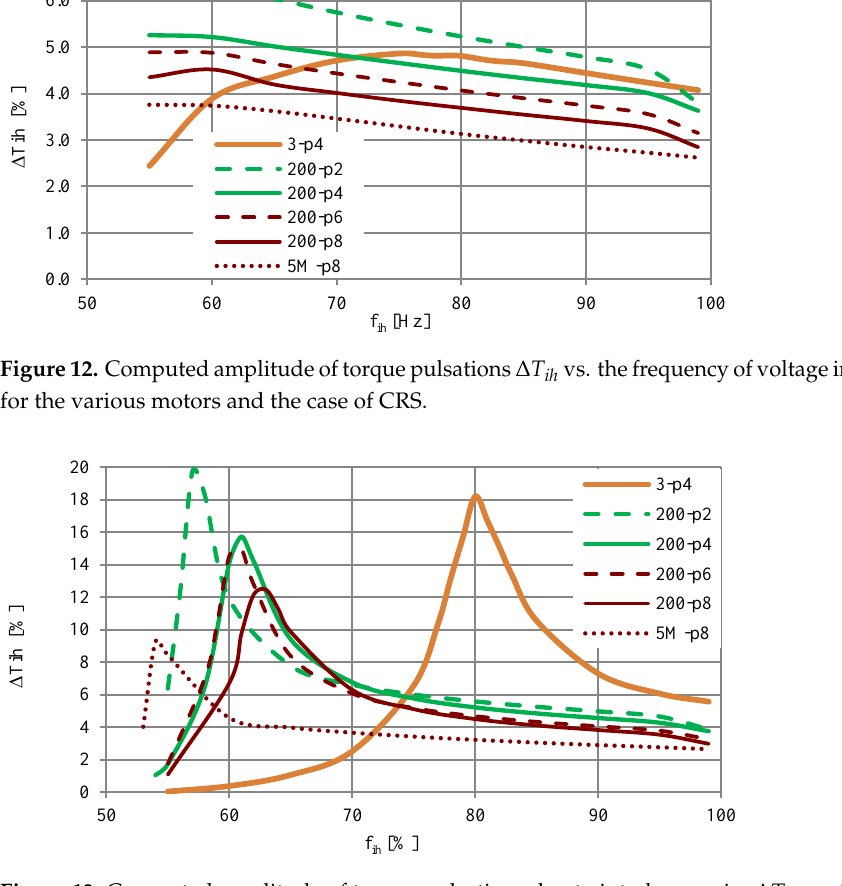
Figure 13. Computed amplitude of torque pulsations due to interharmonics Δ T ih vs. interharmonic frequency for the various motors and the case of NMI.